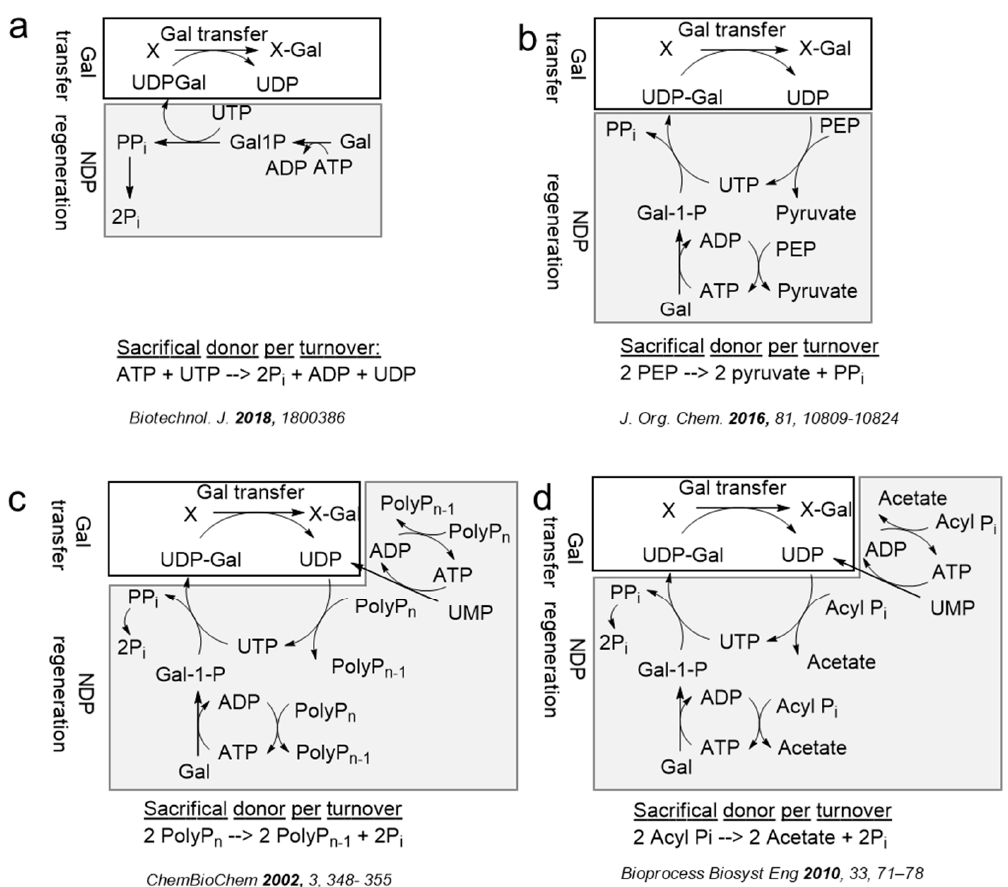
Figure 9. Several sacrificial phosphate donors for sugar nucleotide (re)generation systems of galactosyltransferases using a stoichiometric amount of NTPs ( a ) [199], PEP ( b ) [200], PolyP n ( c ) [189], and acyl P i ( d ) [201]. Abbreviations: PP i , pyrophosphate; P i , orthophosphate; UMP, uridine monophosphate; UDP, uridine diphosphate; UTP, uridine triphosphate; UDP-Gal, UDP- D -galactose; ADP, phosphate.